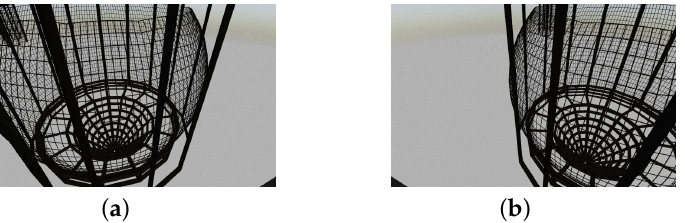
Figure 2. Input images from the vehicle cameras: ( a ) left camera’s image; ( b ) right camera’s